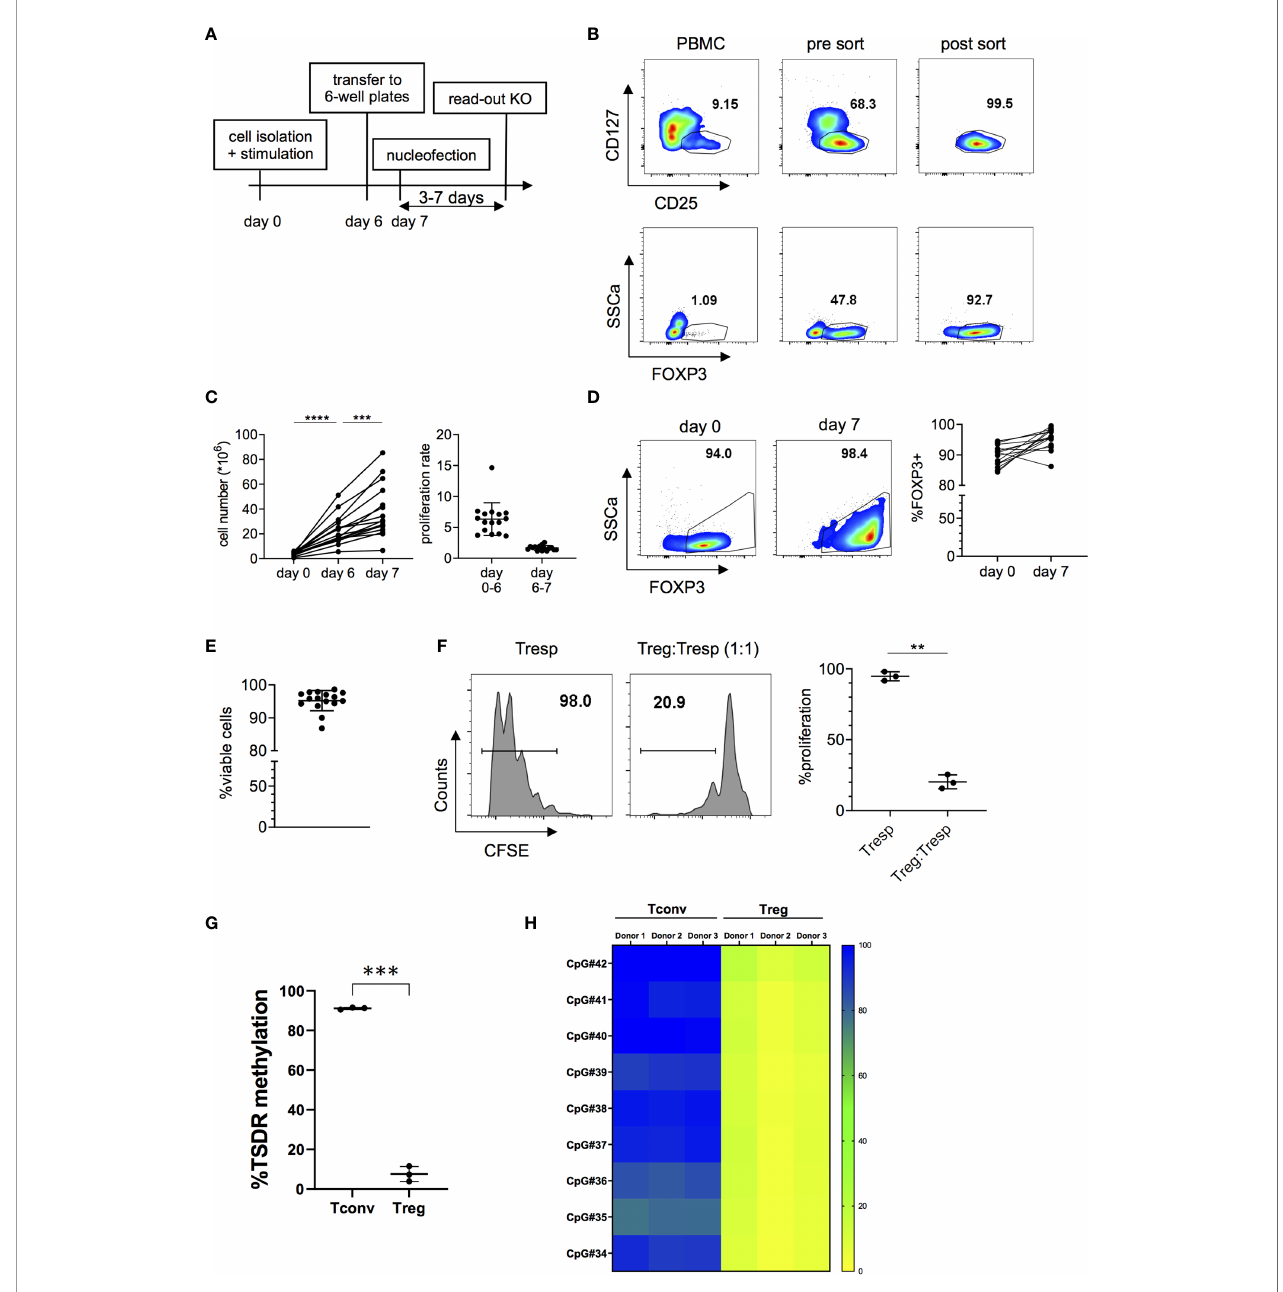
FIGURE 1 | Isolation and in vitro expansion of human Tregs. (A) Schematic overview of the cell expansion procedure. Tregs are stimulated in vitro for six days with anti-CD3 and anti-CD28 antibodies in the presence of IL-2 and then transferred to 6-well plates 24 hours prior to nucleofection in the absence of TCR stimulation. Read-out of the KO was performed 3 to 7 days after nucleofection. (B) Representative FOXP3 expression before and after FACS sorting CD4 + CD25 + CD127 - cells. (C) Cell numbers (left panel) and proliferation rate (right panel) of in vitro expanded Tregs (n = 16 independent donors). Data is depicted as mean ± SD. (D) FOXP3 expression before stimulation and after seven days in culture of one representative donor (left panel) and 16 independent donors (right panel). (E) Cell viability after seven days in culture (n = 16 independent donors). Error bars represent mean ± SD. (F) Suppressive capacity of Tregs after seven days of in vitro culture, measured as the ability of Tregs to suppress CD4 + T cell (Tresp) proliferation. FACS data of one representative donor (left panel) and cumulative data of 3 independent donors (right panel) are shown. (G, H) DNA methylation pattern of the Treg-Speci fi c Demethylation Region (TSDR) assessed in 7 day- in vitro expanded CD4 + CD25 - CD127 + Tconv and CD4 + CD25 + CD127 - Treg cell subsets. (G) Average methylation rate for 9 CpG sites of the TSDR. Each dot denotes a donor (n =3 different donors matched for Tconvs and Tregs). (H) In the heatmap plot, each box represents the percentage of methylation of a single CpG residue for each sample (n= 3 matched donors for Tconvs and Tregs). Bar colors designate: yellow: 0% methylation; green: 50% methylation; blue: 100% methylation. Error bars represent mean ± SD. Signi fi cance was calculated using one-way ANOVA (C) or two-tailed paired t test (F, G) . **p ≤ 0.01, ***p ≤ 0. 001 and ****p ≤